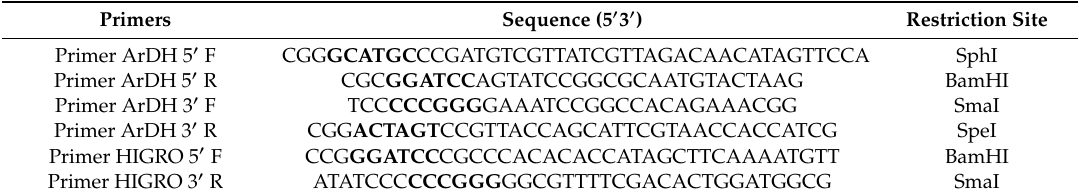
Table 2. Primers used in this study. Restriction enzyme sites are highlighted in